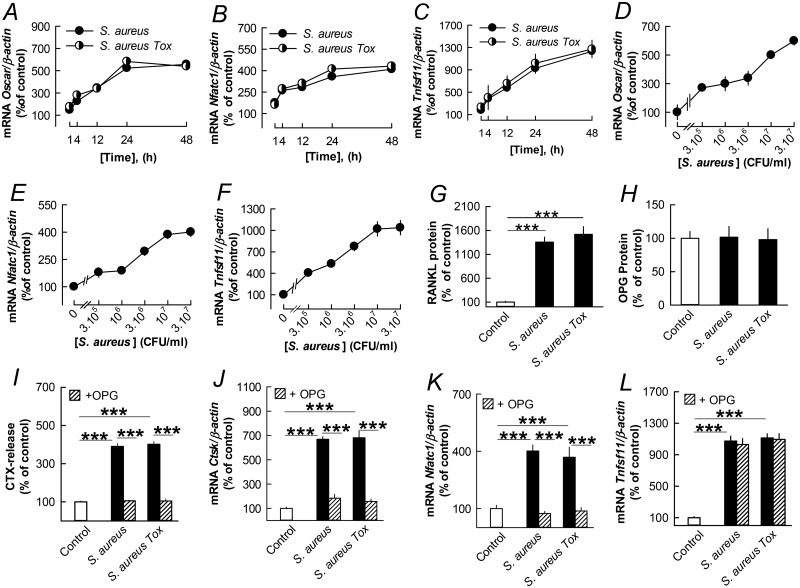
The stimulatory effect on bone resorption in mouse parietal bones by S. aureus is dependent on increased RANKL.(A-C) S. aureus (3x106 CFU/ml) time-dependently increased the mRNA expression of Oscar, Nfatc1 and Tnfsf11in the parietal bones. (D-F) Concentration-dependent effect by S. aureus on Oscar, Nfatc1 and Tnfsf11 mRNA. (G) S. aureus (3x106 CFU/ml) increased the cellular level of RANKL protein without affecting OPG protein. (I-L) The stimulatory effect by S. aureus (3x106 CFU/ml) on CTX release and mRNA expression of Ctsk and Nfatc1 in the parietal bones was inhibited by OPG (300 ng/ml), without any effect of Tnfsf11 mRNA expression. Data are means of 5 (A-F, J -L) or 6 (G-I) observations and SEM is given as vertical bars when larger than the radius of the symbol. In Fig 2A, effects were statistically significant at 4 h (P<0.05) and at 12–48 h (P<0.001). In Fig 2B, effects at 4–48 h were statistically significant (P<0.001). In Fig 2C, effects were statistically significant at 4 h (P<0.05) and at 12–48 h (P<0.001). In Fig 2D, effects were statistically significant at 3 x 105, 107 and 3 x107 (P<0.001) and at 106 and 3 x 106
(P<0.01) CFU/ml. In Fig 2E and F effects at 3 x 105–3 x 107 CFU/ml were statistically significant (P<0.001). ***P<0.001 compared to unstimulated control (G, I-L) or to S. aureus stimulated bones (I-K).